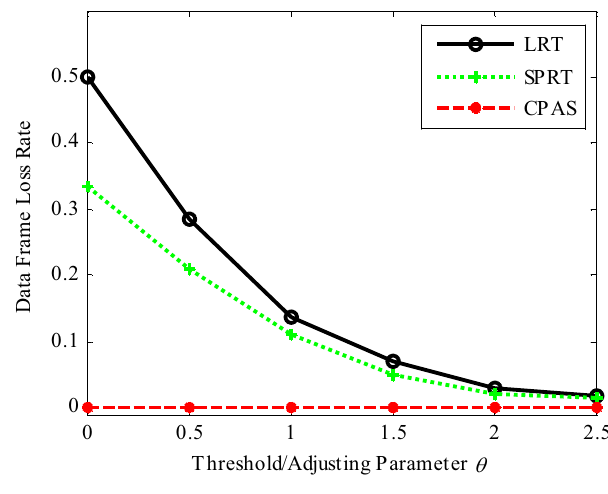
Figure 13. Data frame loss rate.